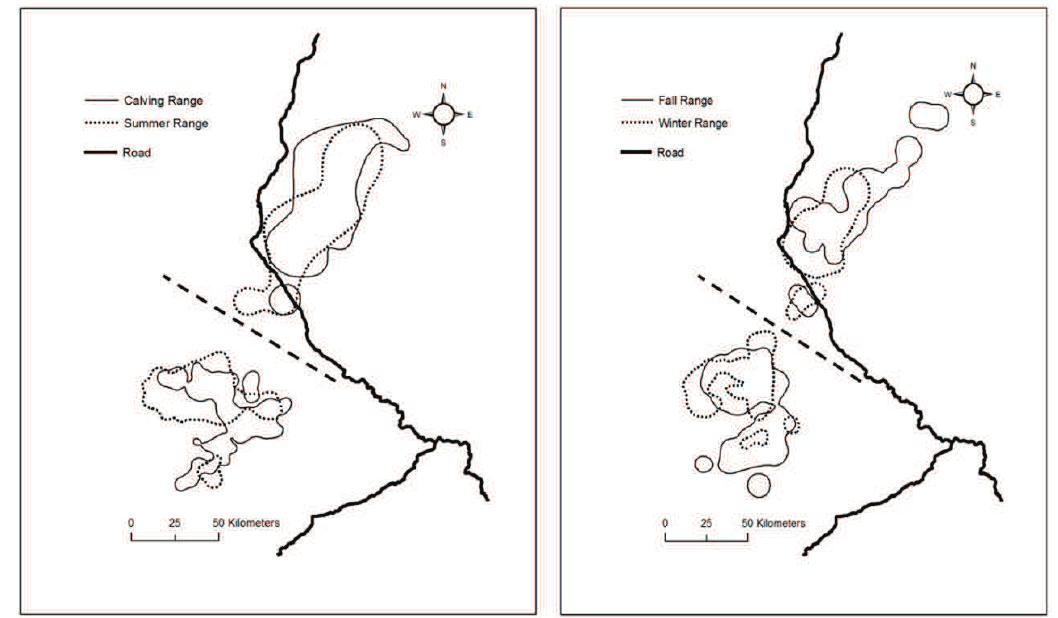
Figure 5. Seasonal ranges (90% cumulative probability contours) of RMH and HHH based on kernel density estimates. Dotted line represents an approximate line of separation between the RMH (southwest of line) and HHC H (northeast of